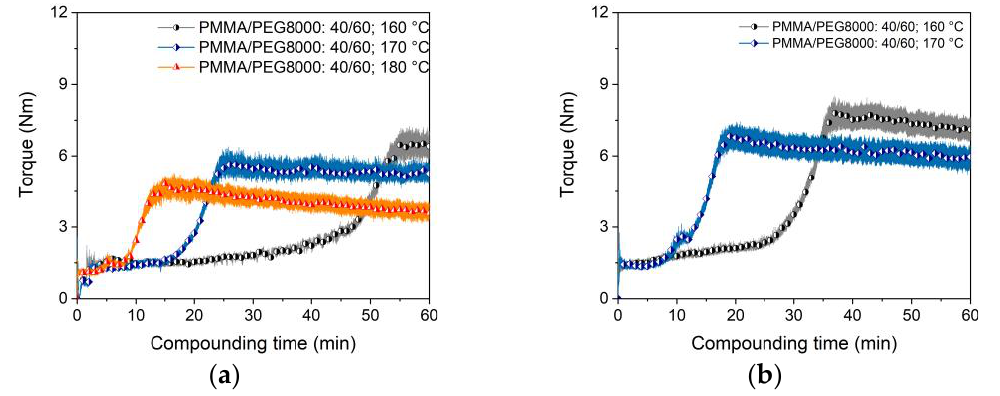
Figure 5. Compounding of PEG/PMMA-based binder and SA as surfactant. ( a ) PMMA/PEG 8000 ratio 40/60 at different temperatures (solid load 60 vol%); ( b ) PMMA/PEG 8000 ratio 40/60 at different temperatures (solid load 65 vol%).